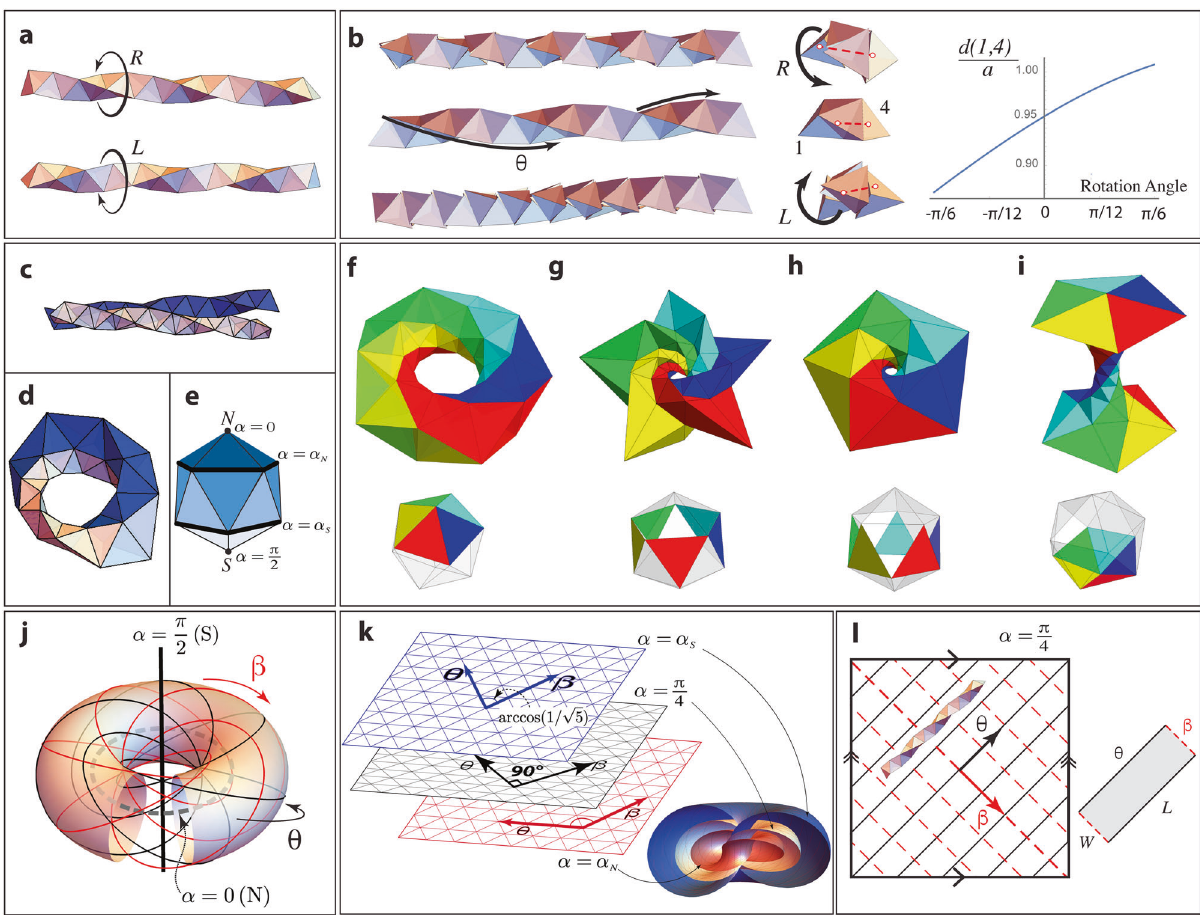
Fig. 2 Structure of the 600 cell. a Tetrahelices are chiral linear assemblies of tetrahedra. b Chiral ligands induce a twist between neighboring tetrahedra, and select and handedness of the tetrahelix. When the tetrahelix and the relative twist have the same (opposite) handedness, the distance between 4th- nearest neighbor tetrahedra ’ s centers d (1, 4) increases (reduces), thus lowering (increasing) their electrostatic repulsion. At the same time, the edges of the tetrahelix become more (less) coiled. c In 3D Euclidean space, two tetrahelices cannot fi t side-to-side. d Two tetrahelices fi tting perfectly together on the 3-sphere S 3 (a stereographic projection). e The base icosahedron of the 600 cell. The 4 toroidal shells are indicated by color gradient, with the α coordinate of the boundaries between them marked. f – g 4 toroidal shells of the 600 cell, each containing 5 tetrahelices. f North pole bundle (0 < α < α N ): 5 tetrahelices around the North pole of the base. g North ring of 5 tetrahelices wrapped around the North pole bundle (the latter is not visible). h South ring of 5 tetrahelices wrapped around the North ring. The surface triangles are facing the South pole of the base. The north and south rings together occupy the space α N < α < α S . i South pole bundle ( α S < α < π /2): 5 tetrahelices are closely packed around the South pole of the base. j The coordinate Φ μ = ( α , β , θ ) (stereographic projection). k The slice (cid:1) M , which contains the north and south rings ( g and h , a total of 300 tetrahedra arranged in 10 tetrahelices, corresponding to the middle 10 triangles in the base icosahedron in e ), are characterized by layers of constant α surfaces within α N < α < α S . The angle between ( θ , β ) evolves across the layers, according to the reference metric [Eq. (4)]. l The middle layer of (cid:1) M is the Clifford torus ( α = π /4, represented as a square with opposite edges identi fi ed). The θ axis is along the RH tetrahelices, and along the long side of the ribbon when RH tetrahelices assemble. The assembled ribbon (gray rectangle) has reference metric (cid:1) g from the 600 cell but is not limited by the size of the Clifford plane metric of the mid-surface. The reference second funda- (cid:1) b represents the reference curvature. It is off- mental form diagonal, so it favors pure twist around the axis de fi ned by the tetrahelix direction. The twist between the contact surfaces of the tetrahelices packed in the shell generates stress between the upper and lower surfaces of the sheet, as depicted in Fig. 2k. This (cid:1) b are geometric frustration manifests in the fact that (cid:1) a and incompatible in a surface embedded in Euclidean space for which Note that the